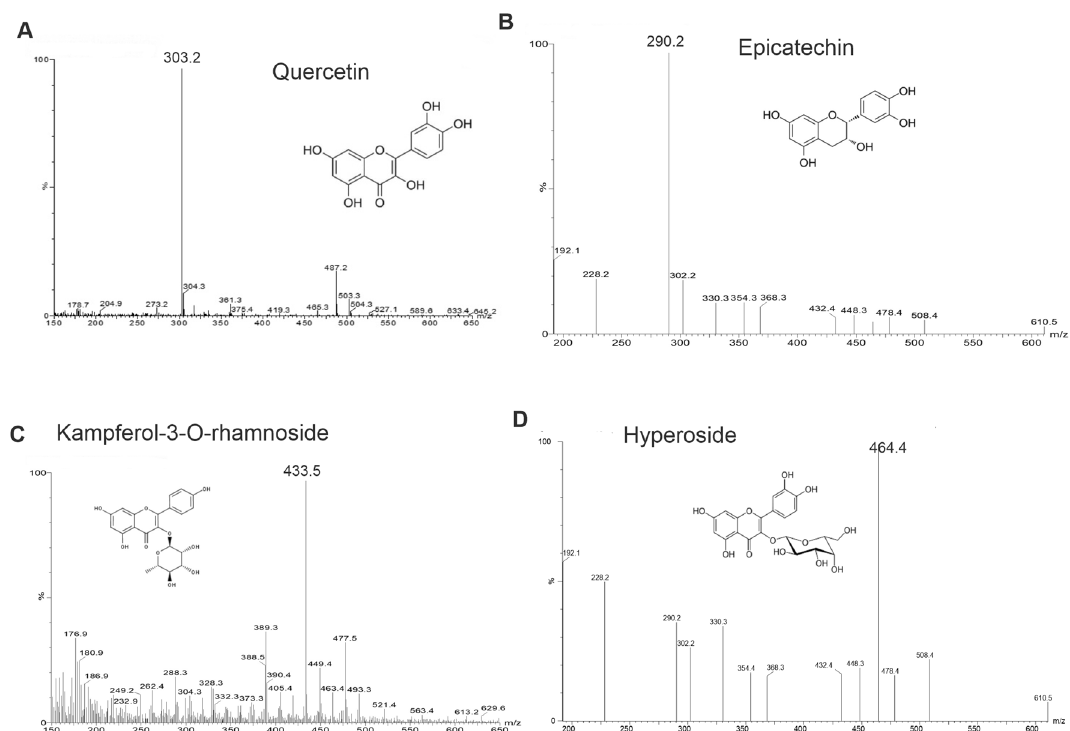
Figure 2. Identification of compounds in plant extracts. ESI–MS data for four main compounds isolated by HPLC from M20 and EA80 plant fractions. ESI–MS data were collected in positive ion mode. Molecular ions were observed either as a radical M+ or a protonated form [M + H]+. Based on mass-to-charge ratios (m/z), the compounds were preliminarily identified as ( A ) quercetin (m/z = 303.2, [M + H]+), ( B ) epicatechin (290.2,